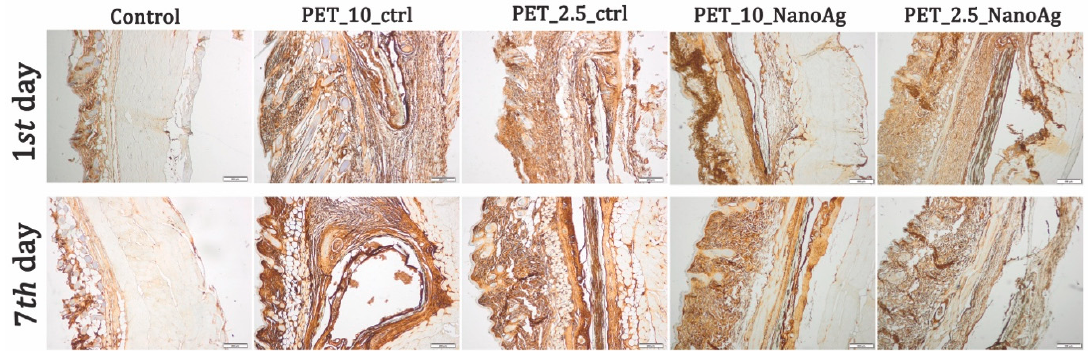
Figure 15. Expression and specific distribution of tumor necrosis factor (TNF)- α at implantation site at 24 h and seven days after implantation; scale bar = 200 μ m.